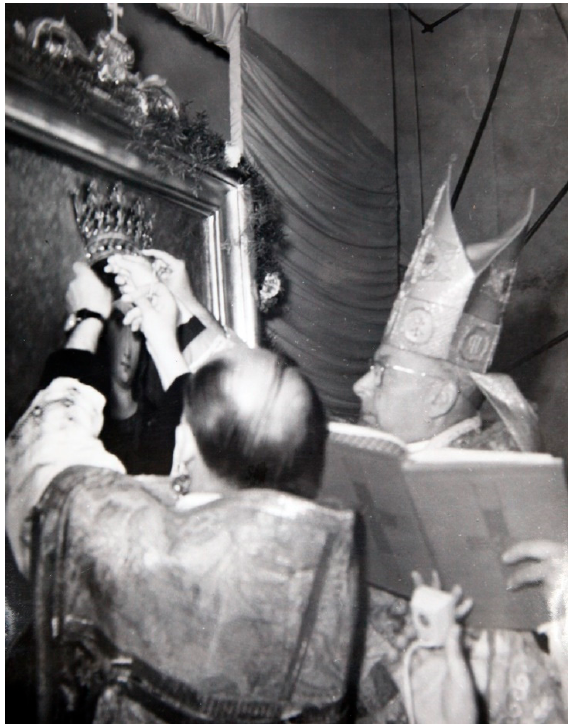
Figure 7. The Primate of Poland, Cardinal Stefan Wyszy ń ski, crowns the image of Our Lady of Rychwa ł d in Rychwa ł d (18 July 1966) (photo: Archives of the Sanctuary of Our Lady of Rychwa ł d in Rychwa ł d).